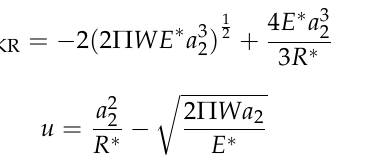
the number r 12